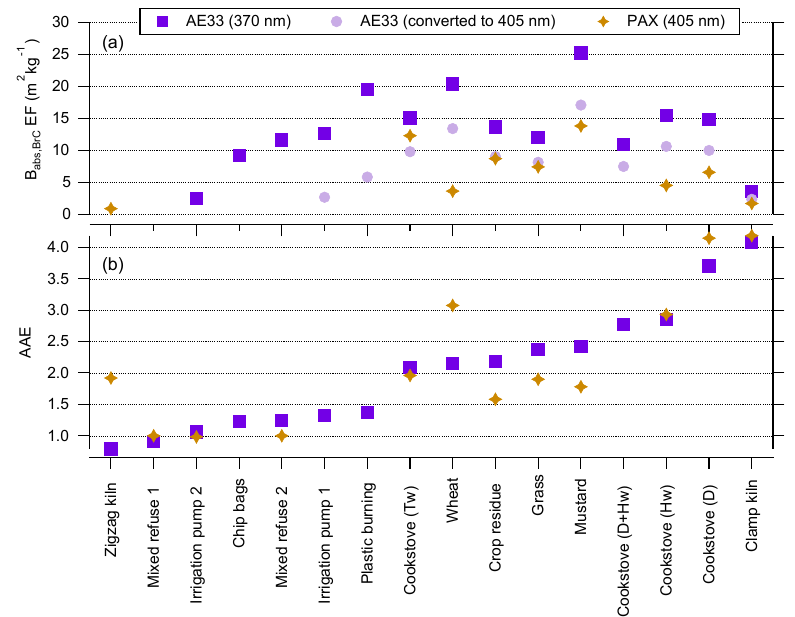
Figure 5. (a) Emission factor of aerosol absorption due to brown carbon detected at 370nm by the AE33, converted to 405nm, and at 405nm by the PAX system (Stockwell et al., 2016). (b) Absorption Ångström exponent (AAE) for the investigated emission sources. Cookstove fuel types are hardwood (Hw), dung (D), and sticks and twigs